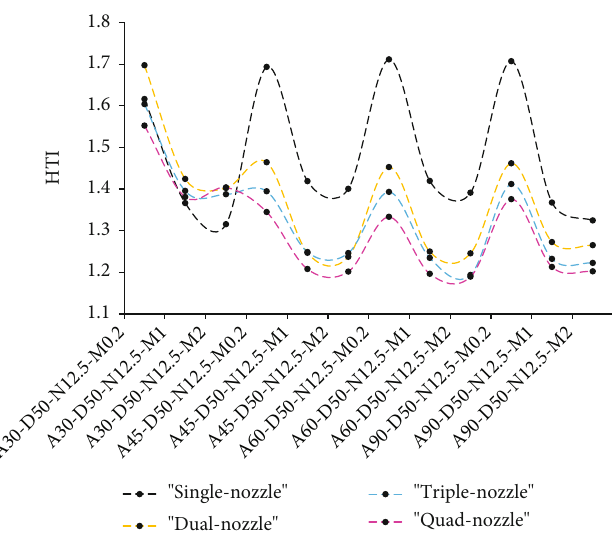
Figure 8: Heat transfer improvement index (HTI).